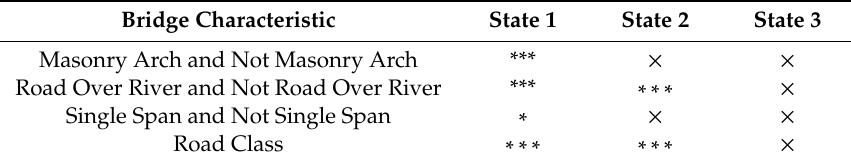
Table 2. A table showing the results of the hypothesis test for each of the characteristics for the time spent in condition states 1, 2 and 3 where * indicates significance at 5% level, ** highly significant, *** very highly significant and × denotes the test was insignificant at the 5% level. Bridge Characteristic State 1 State 2 State 3 Masonry Arch and Not Masonry Arch *** × × Road Over River and Not Road Over River *** ∗ ∗ ∗ × Single Span and Not Single Span ∗ × × Road Class ∗ ∗ ∗ ∗ ∗ ∗